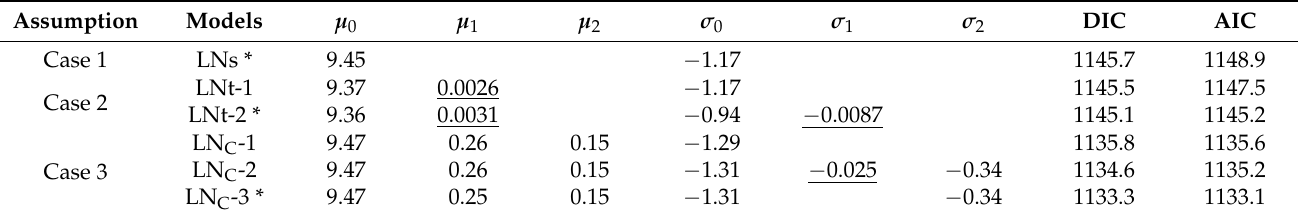
Table 3. Models fitting results for AMFP in different assumptions.